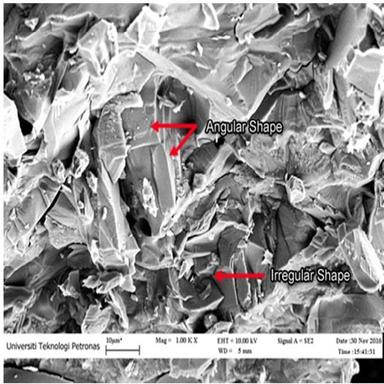
(a): FESEM image of Coal bottom ash at 1000x magnification.